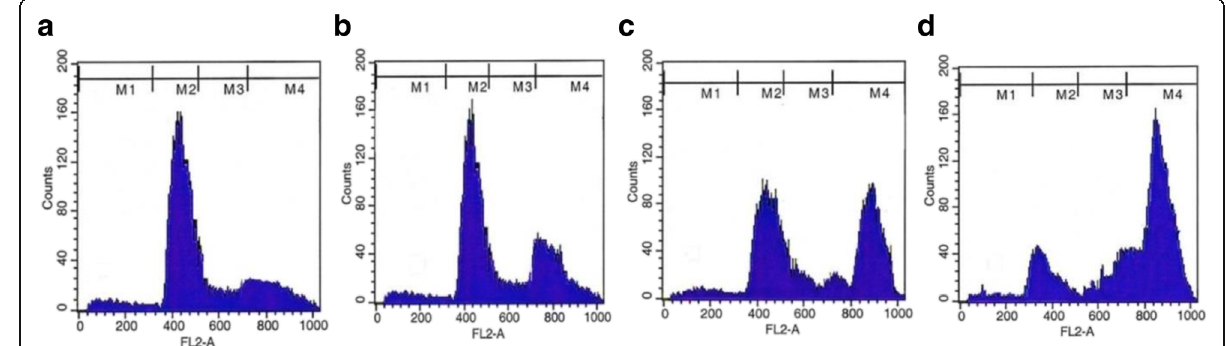
Fig. 10 PI-FACS analysis of fungal EDT-treated HepG2 cells indicated that cells were arrested in the G2/M phases of cell cycle and subG1 phase with significant effect at 128.4 μ M of EDT. a Untreated control cells, ( b-d ) HepG2 cells treated with 32.1 μ M, 64.2 μ M and 128.4 μ M, respectively of fungal